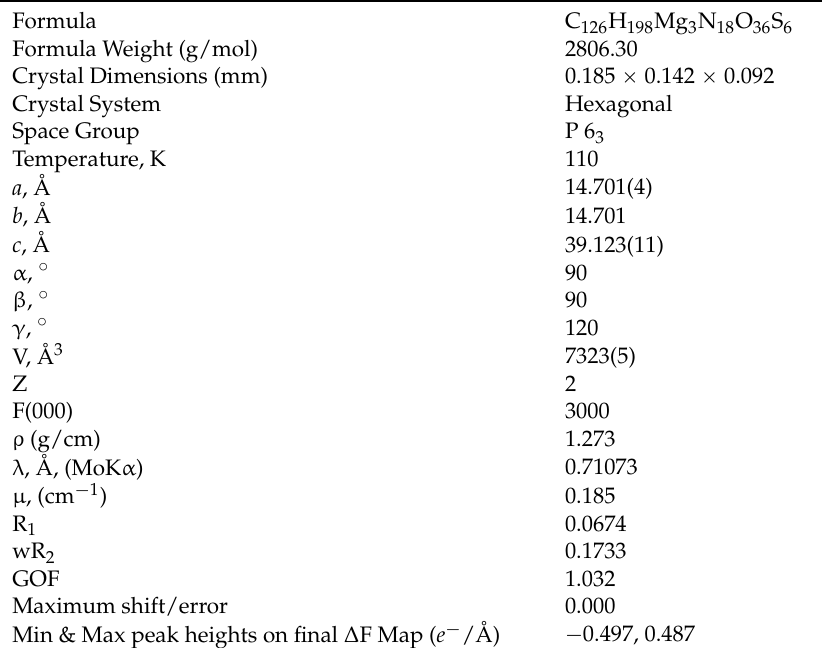
Table 1. Summary of Crystal Data.